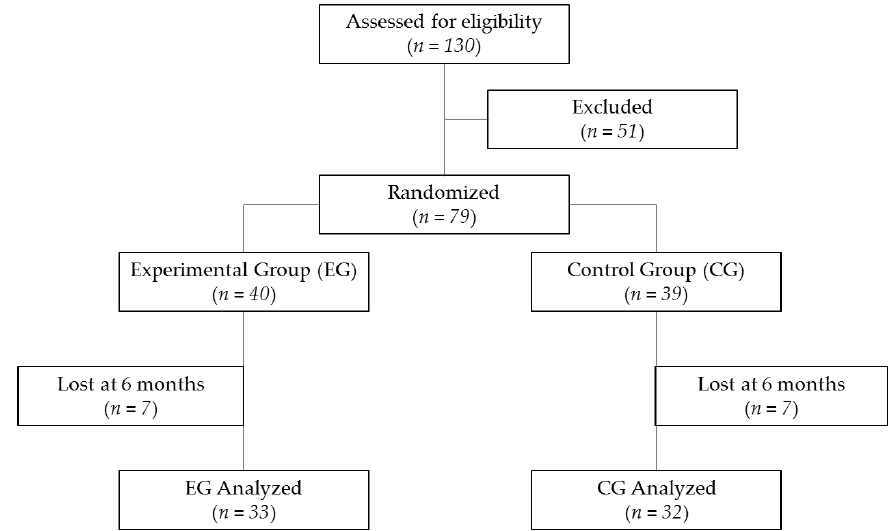
Figure 1. Flow chart describing the present trial.